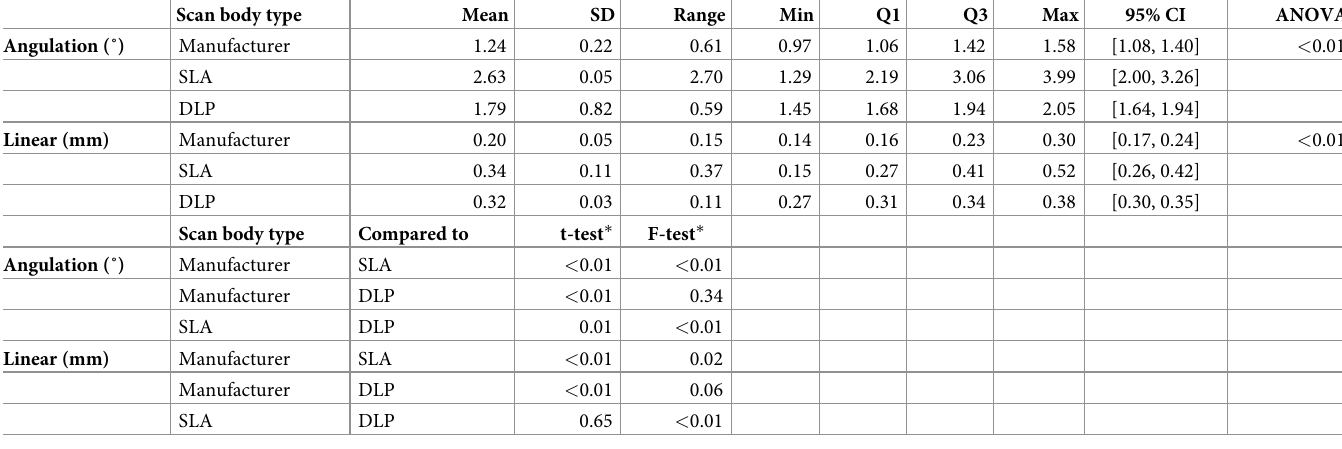
Table 1. Data and statistical analyses for angulation and linear deviations. Scan body